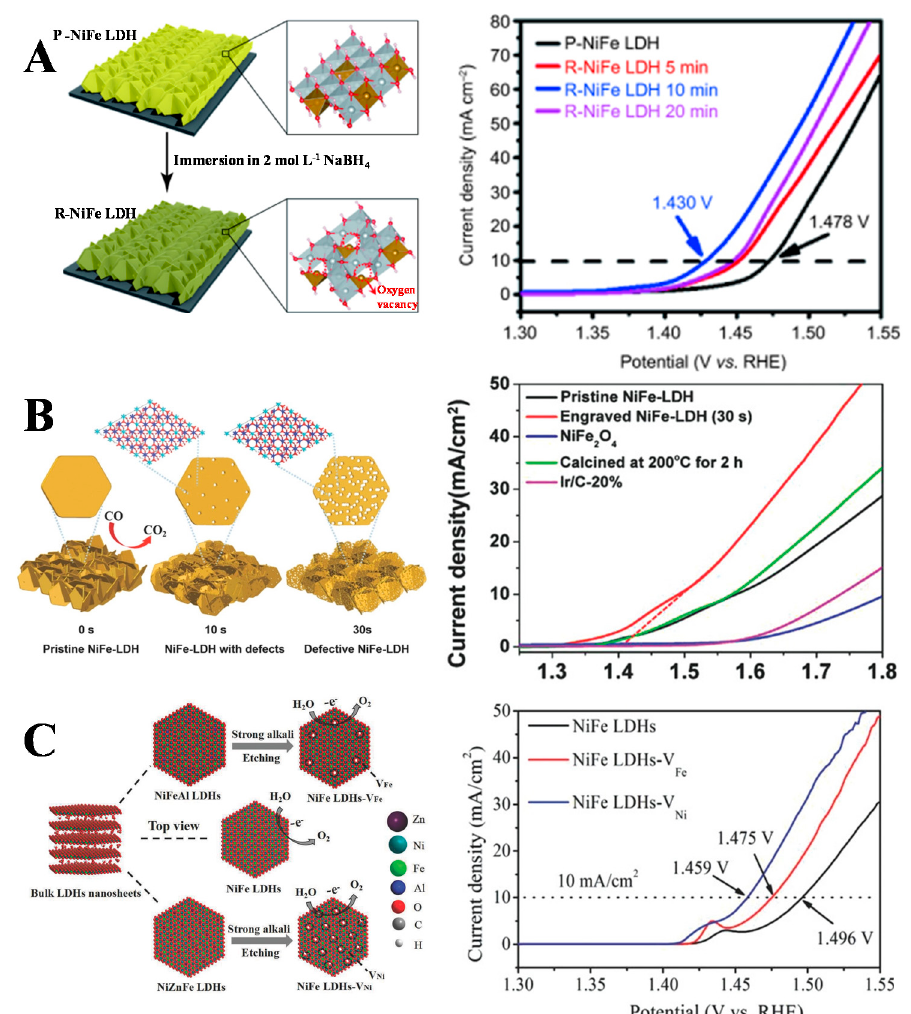
Figure 8. ( A ) Schematic illustration of introducing oxygen vacancy defects to NiFe-LDHs nanoarray electrode and the corresponding OER performance [155]. Copyright © Science China Press and Springer-Verlag GmbH Germany 2018. ( B ) Schematic illustration of defective NiFe-LDH with oxygen vacancies prepared by fast reducing flame treatment for different periods of time and the corresponding OER performance [151]. Copyright © 2018 WILEY-VCH Verlag GmbH & Co. KGaA, Weinheim. ( C ) The synthesis of NiFe LDHs-V Fe and NiFe LDHs-V Ni by strong alkali etching LDHs and the